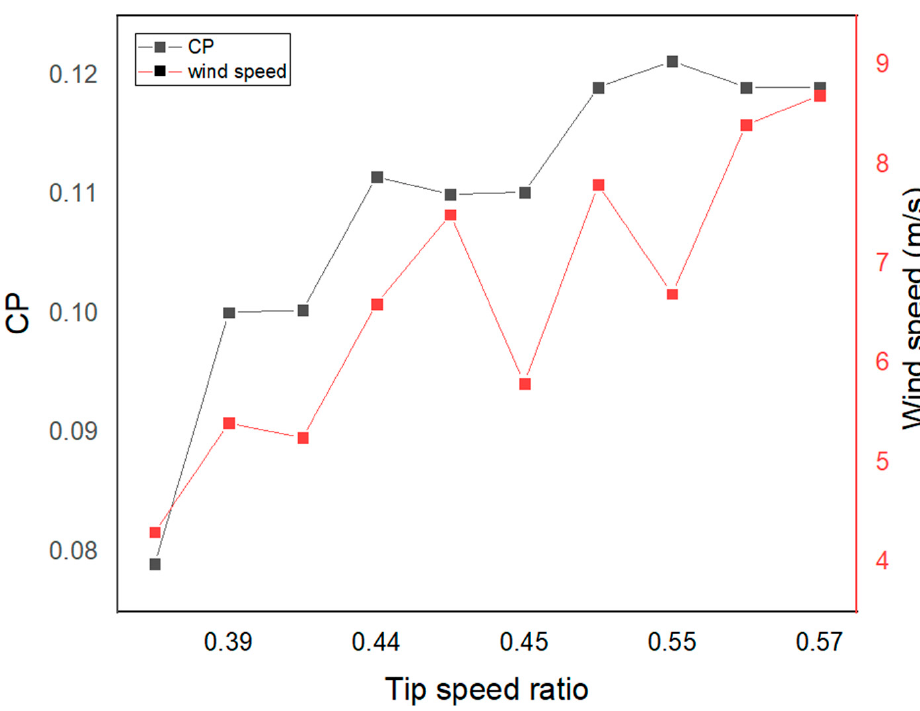
Figure 11. C p and tip speed ratio.